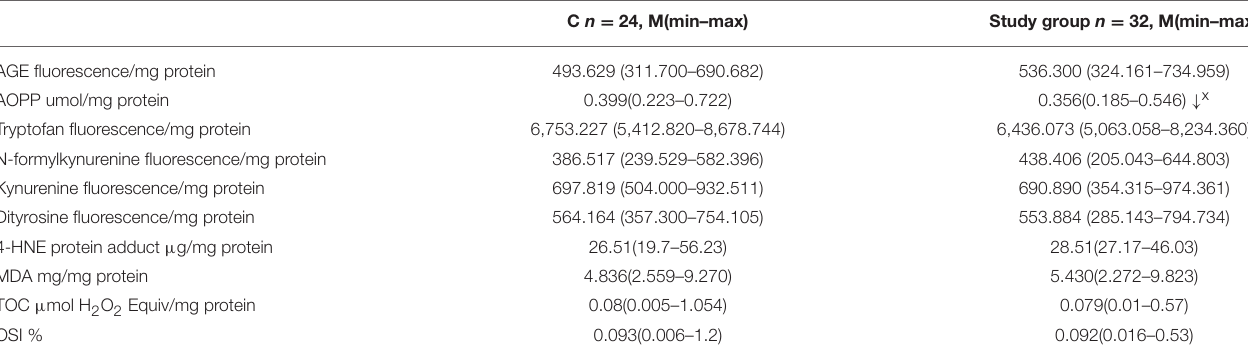
TABLE 2 | Oxidative modification products and markers of oxidative stress in the plasma of the control and examined patients.